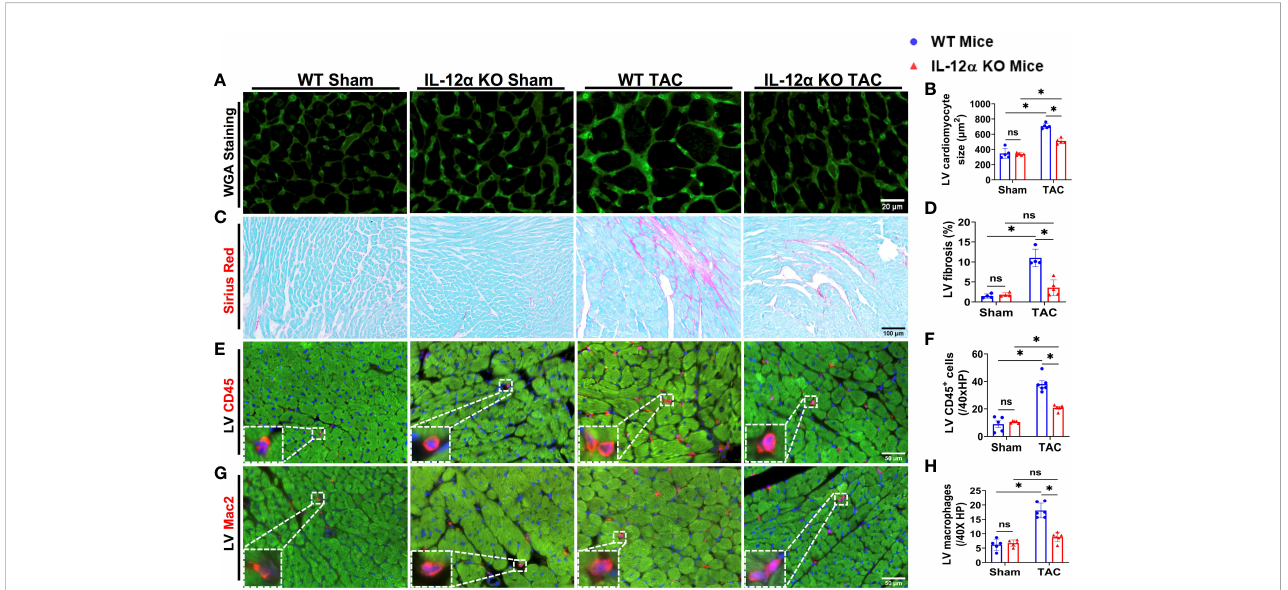
FIGURE 2 IL-12 a KO signi fi cantly attenuated TAC-induced LV cardiomyocyte hypertrophy, fi brosis, and leukocyte in fi ltration. (A, B) Representative images and quanti fi ed data of LV cardiomyocyte size determined by FITC conjugated wheat germ agglutinin (WGA) staining. (C, D) Representative images and quanti fi ed data of LV fi brosis performed by Sirius red/Fast green staining. (E – H) Representative images and quanti fi ed data of LV leukocyte or macrophage accumulation performed by immuno-histological staining. *p<0.05; ns, non-signi fi